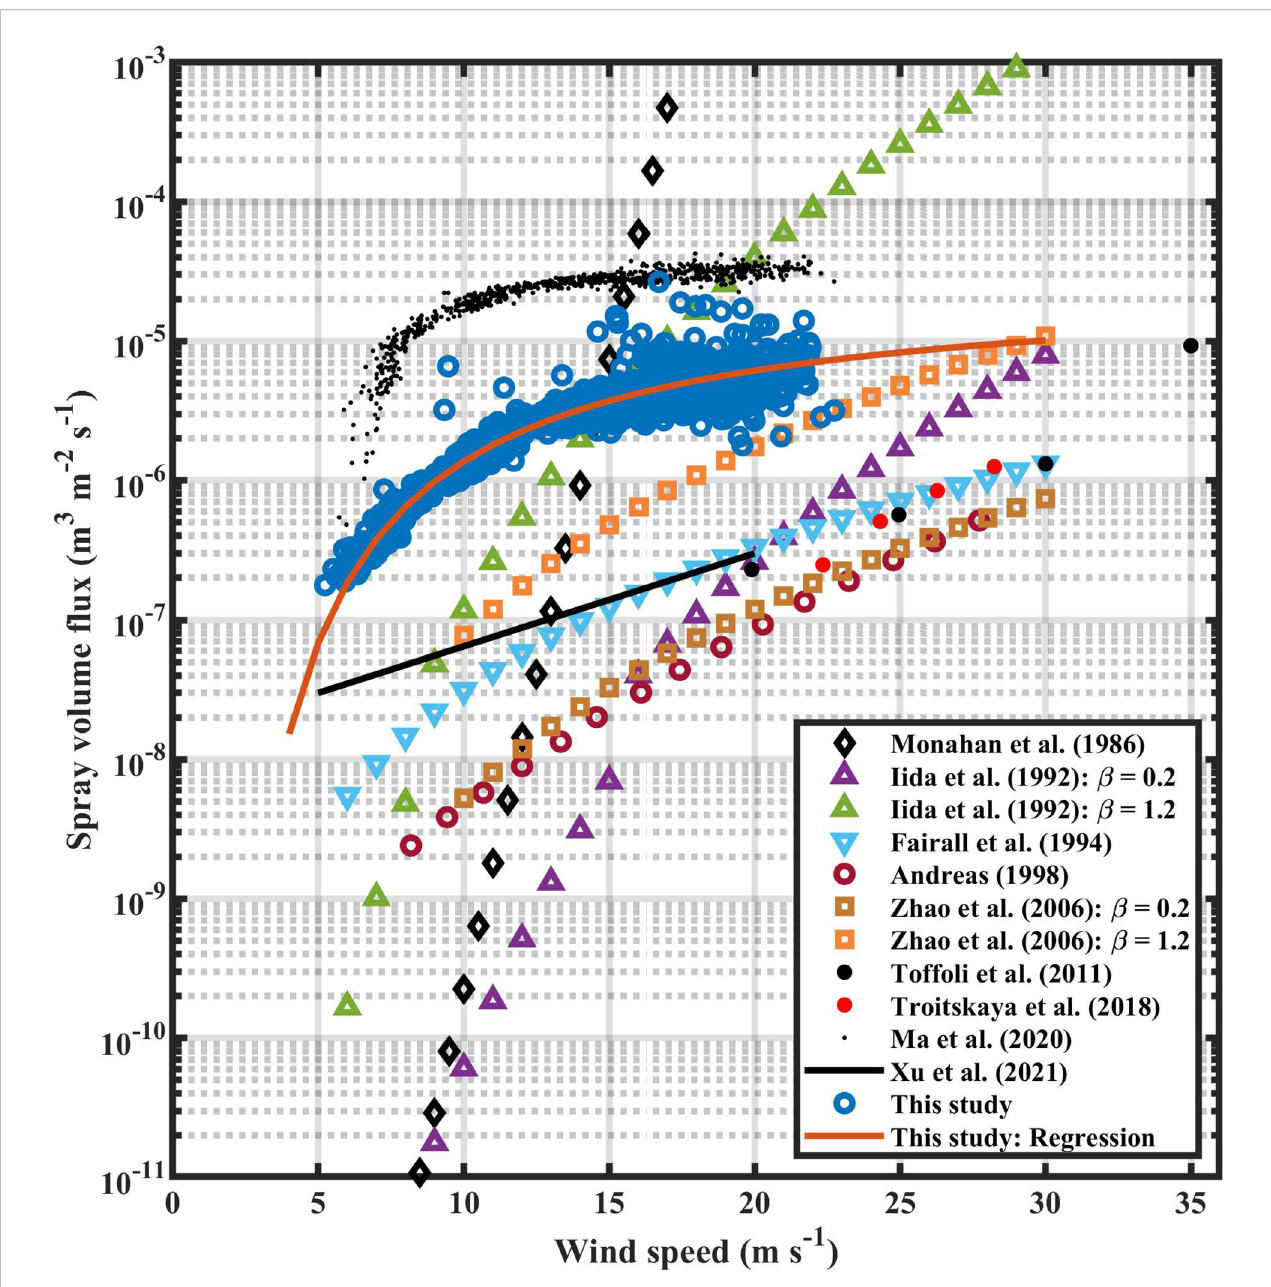
FIGURE 5 Spray volume fl ux against wind speed. Blue circles are the results of this study for the fi eld observations. Monahan et al. (1986); Iida et al. (1992); Fairall et al. (1994), D. Zhao et al. (2006); Toffoli et al. (2011); Troitskaya et al. (2018); Ma et al. (2020) are also given for comparison. The black solid line represents an approximation of Xu et al.